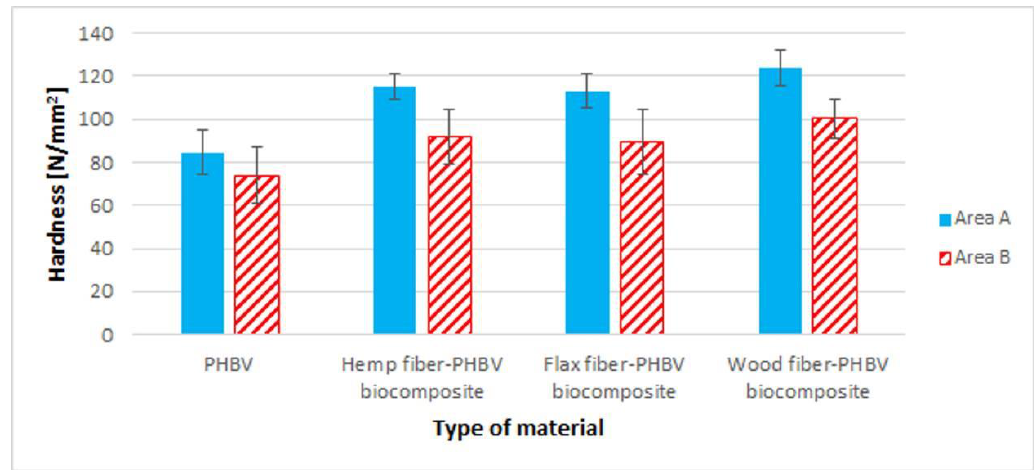
Figure 9. Hardness for pure polymers and biocomposites with various filler types for A and B areas.